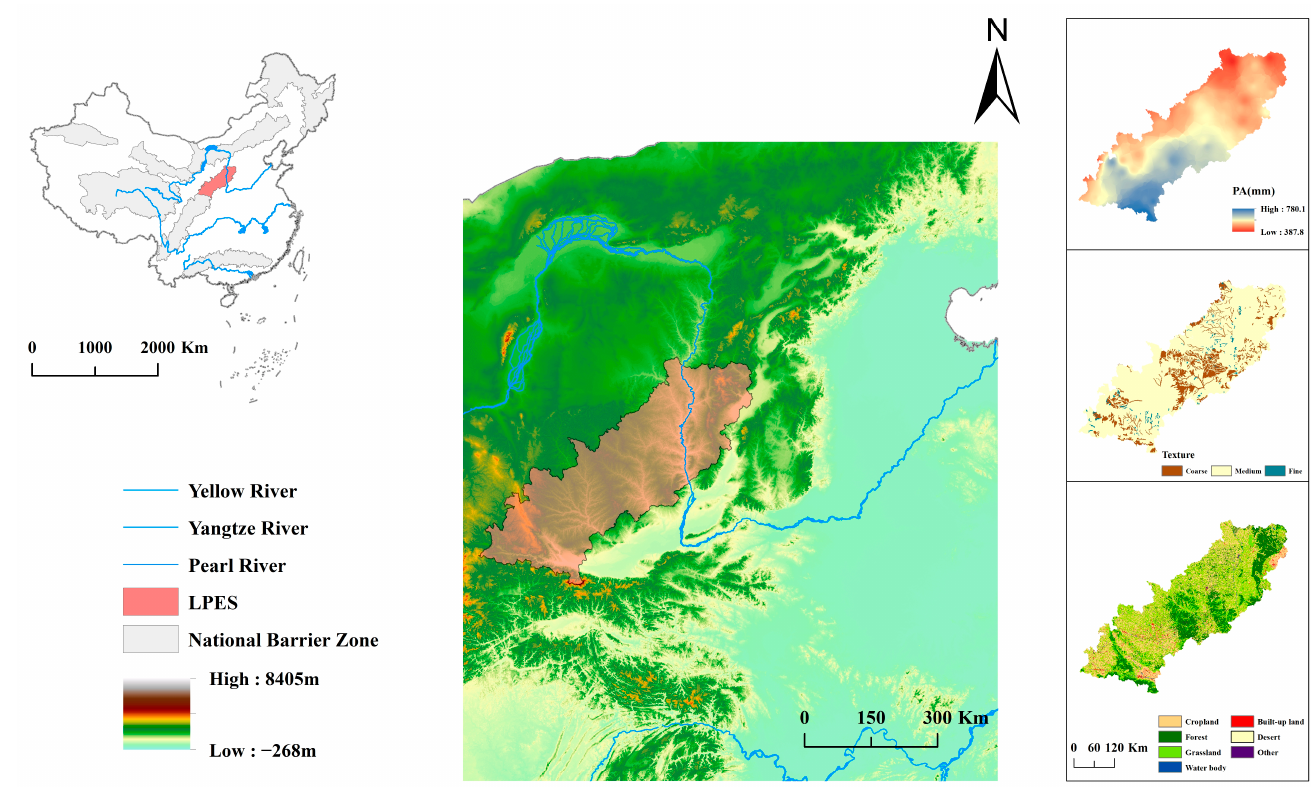
Figure 1. The geographical location of the research area.